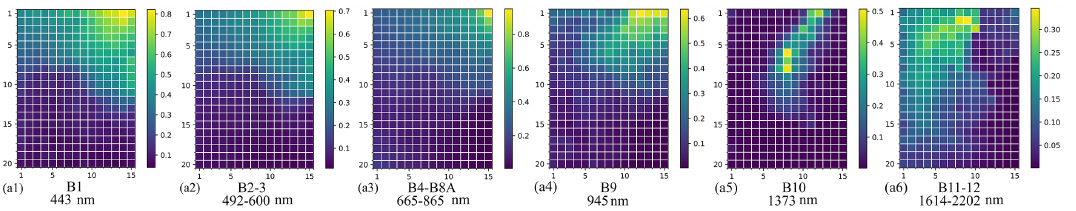
Figure 6. Component planes.